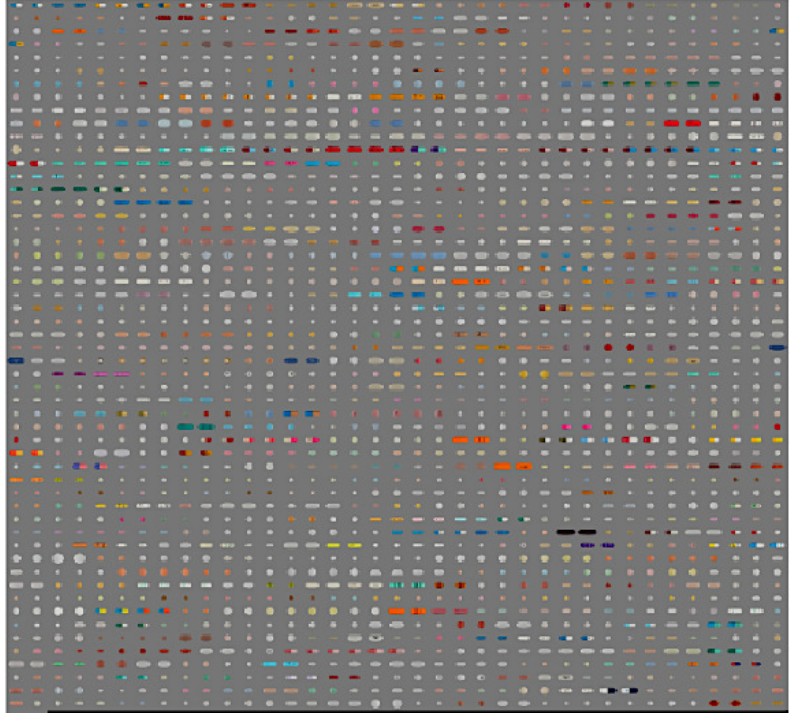
Figure 8. Matching the NLM dataset consumer pill images with reference pill images using the proposed